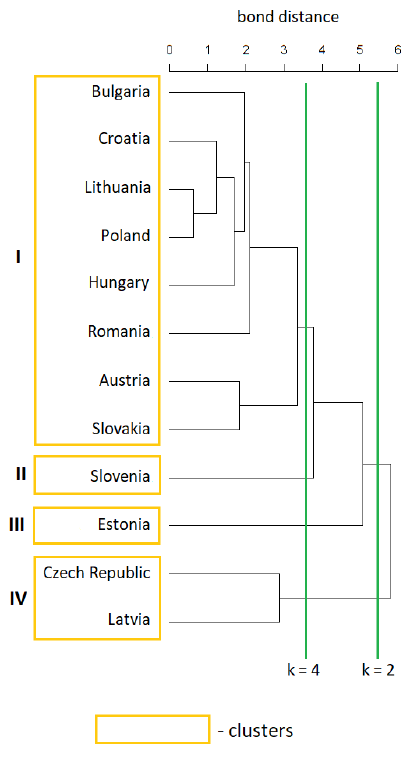
Figure 6. Dendrograms of indicators describing the biogas market in 2021.